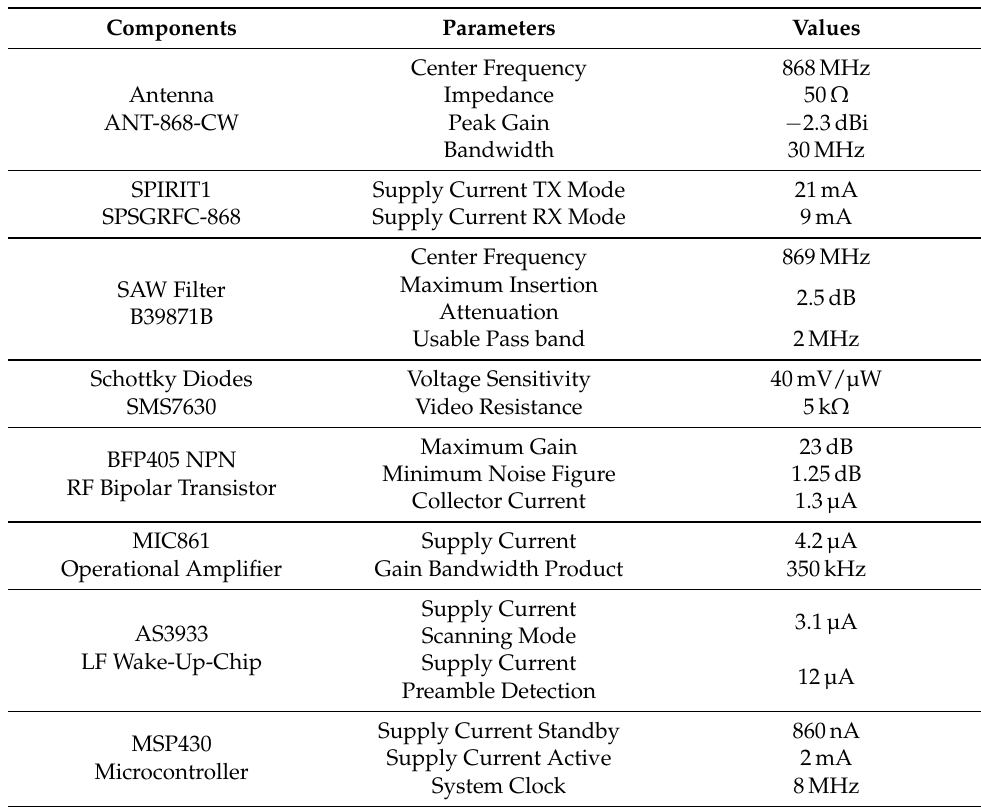
Figure 14. PCBs of the proposed architectures. 1—bandpass filter, 2—envelope detector, 3—LF WuRx IC, 4—TIA amplifier, 5—BJT amplifier. Table 2. Summary of component values for the wake-up